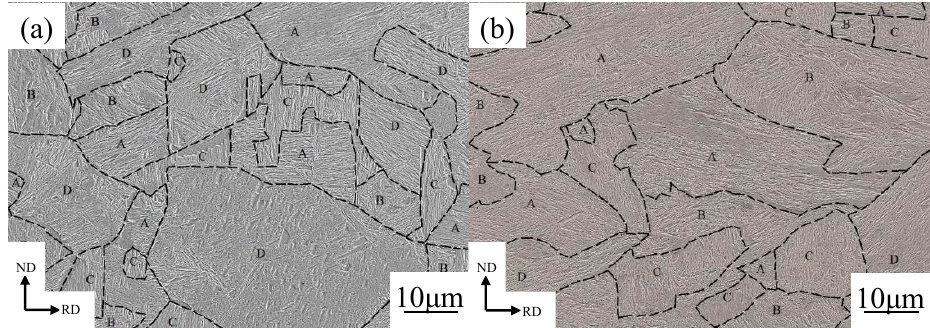
Figure 3. Optical microscopy (OM) image ( a ) and scanning electron microscopy (SEM) image ( b ) showing the microstructures of the as-quenched martensite in the experimental steel.